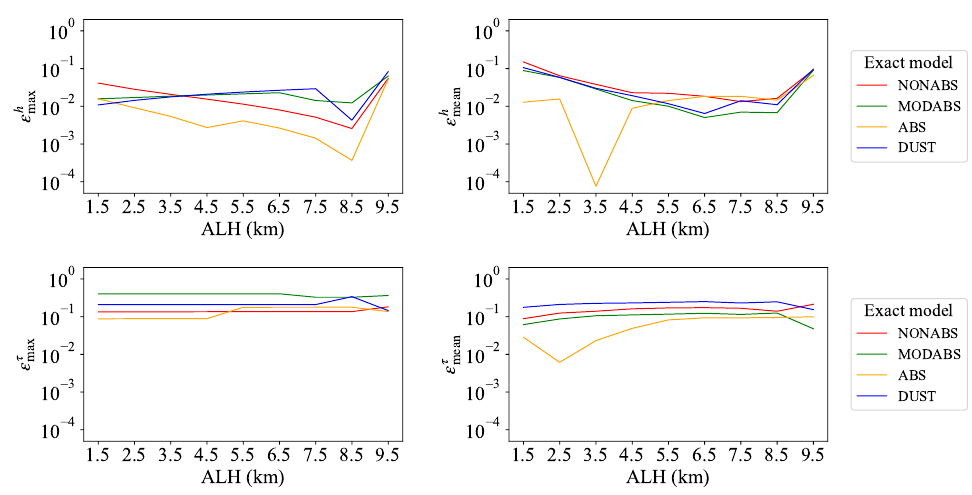
Figure 4. Relative errors ε τ , h mean,max ( τ e = 0.5, h e ) for the aerosol models from Set 2.